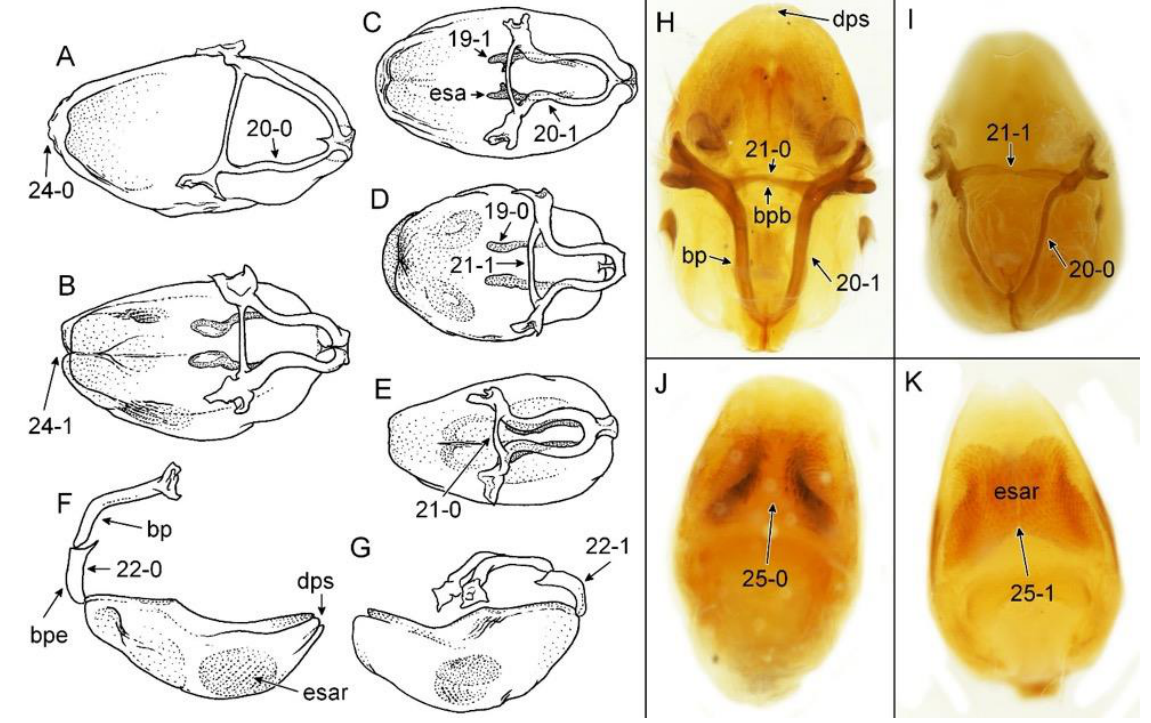
Figure 5. Morphological characters: ( A ) Phonoctonus principalis Gerstaecker, 1892; ( B ) P. lutescens (Guérin-Méneville & Percheron, 1834); ( C ) P. immitis Stål, 1865; ( D ) P. nigrofasciatus Stål, 1855; ( E , F ) P. luridus Miller, 1950; ( G ) P. bifasciatus Villiers, 1948; ( H ) P. fasciatus (Beauvois, 1805); ( I ) P. principalis Gerstaecker, 1892; ( J ) P. luridus Miller, 1950; and ( K ) P. lutescens (Guérin-Méneville & Percheron, 1834), aedeagus.